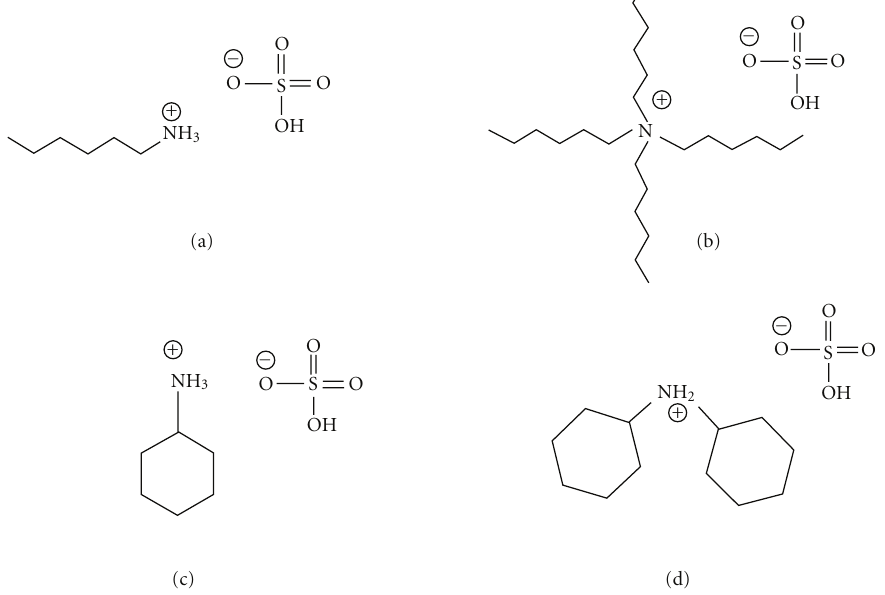
Scheme 1: Molecular structure of (a) hexyl ammonium hydrogen sulphate, (b) tetrahexyl ammonium hydrogen sulphate, (c) cyclohexyl ammonium hydrogen sulphate, (d) bicyclohexyl ammonium hydrogen